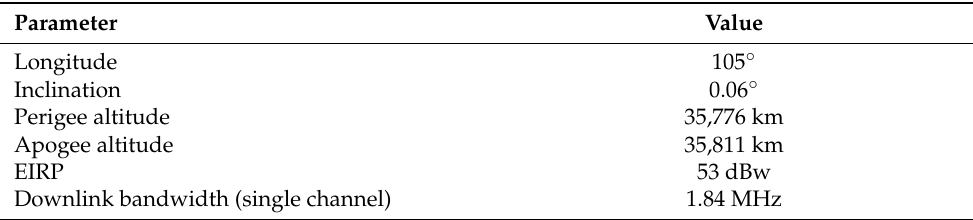
Table 4. Parameters of AsiaStar.